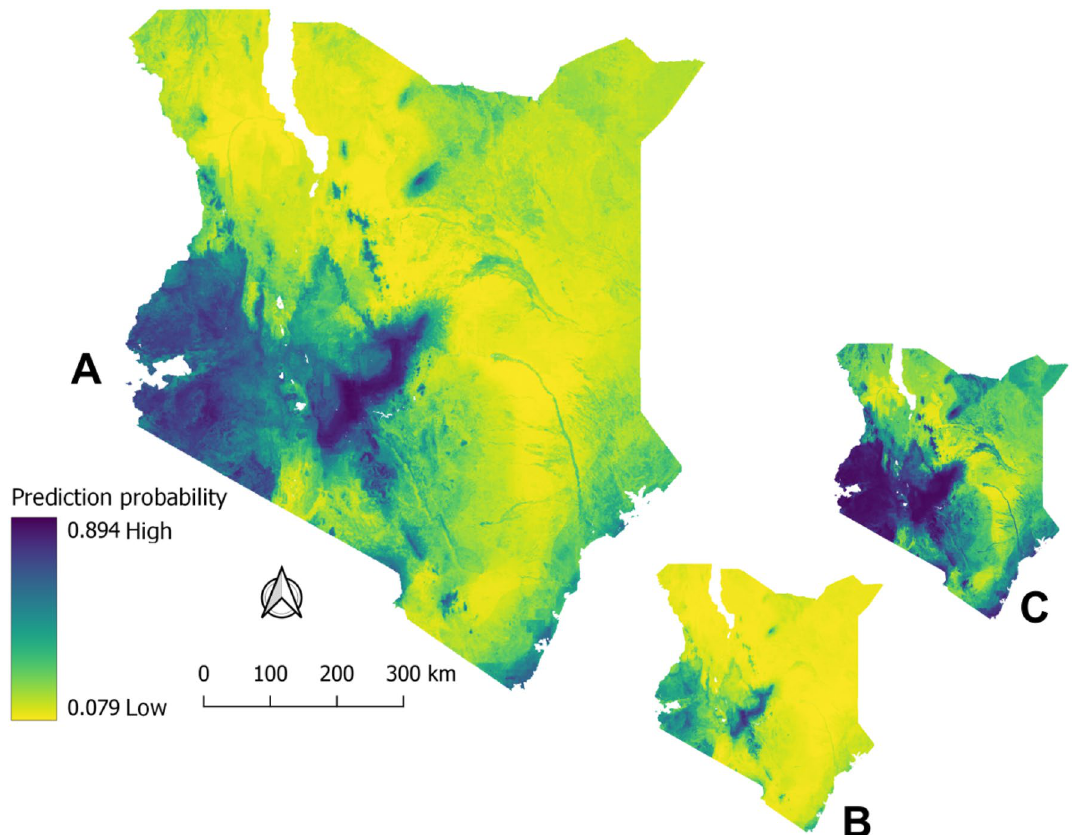
Figure 1. Panel ( A ): Extrapolated geographic prediction for anthrax to the whole of Kenya landscape using southern Kenya-derived 100 BRT experiments. ( B ) shows the lower 2.5% and ( C ), the upper 97.5% confidence intervals. This figure was generated using R software version 4.2.2. at http:// cran.r- proje ct.